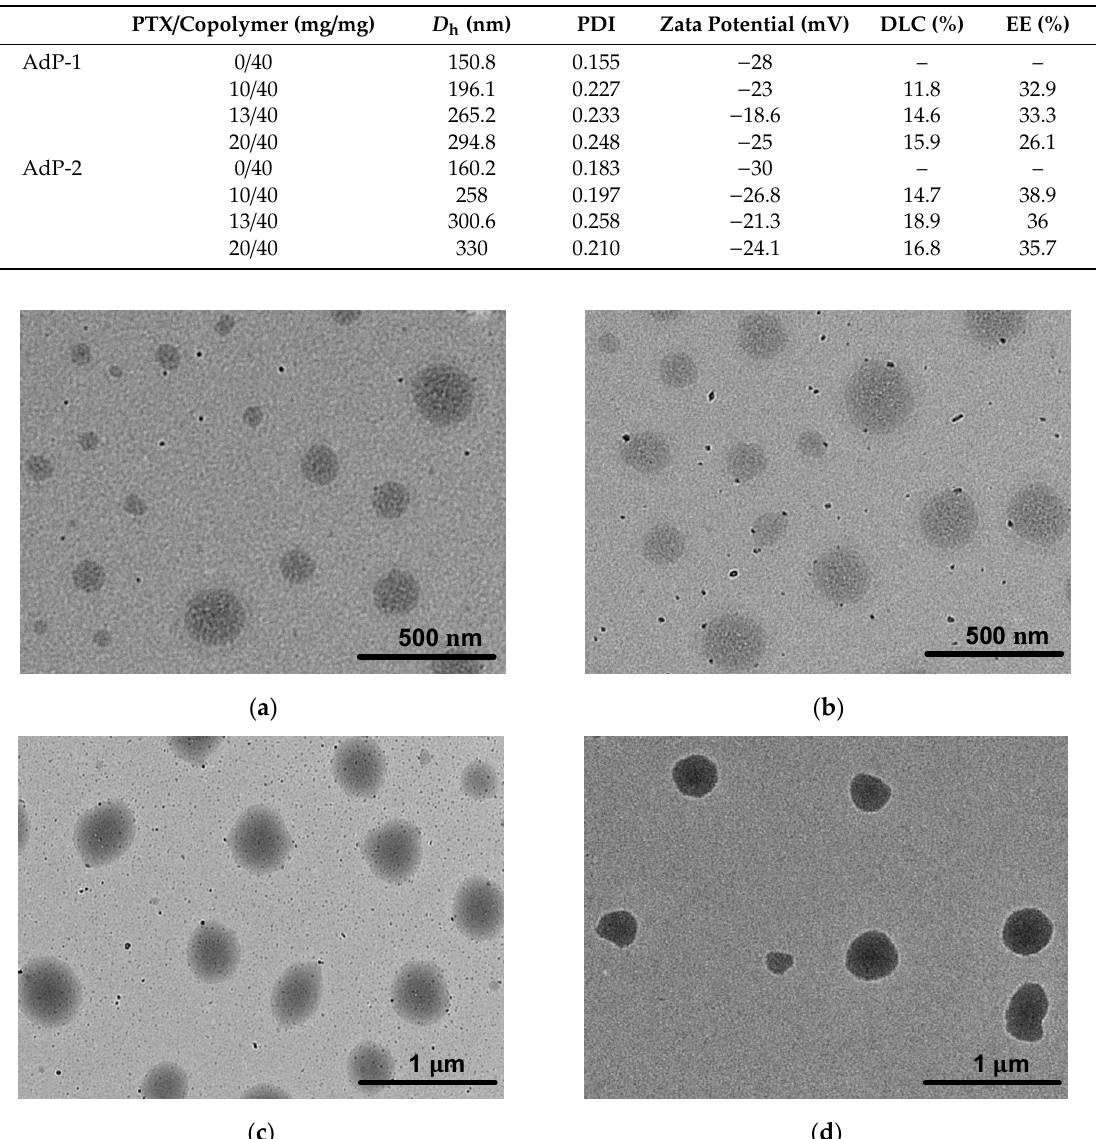
Figure 7. In vitro release profiles of PTX-loaded micelles. Table 3. In vitro release kinetics equation simulation of the nano-carriers. Model